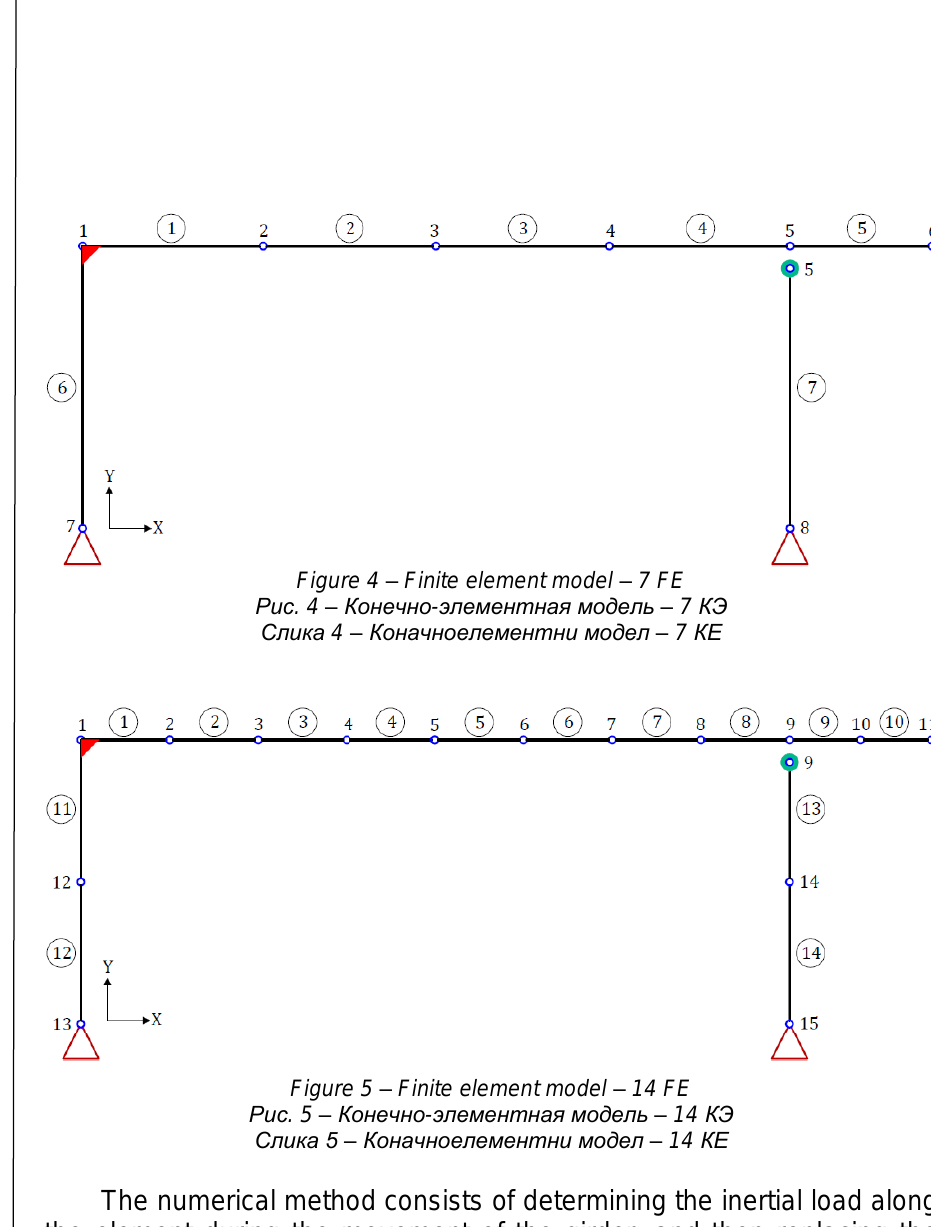
Figure 5 – Finite element model – 14 FE Рис. 5 – Конечно-элементная модель – 14 КЭ Слика 5 – Коначноелементни модел – 14